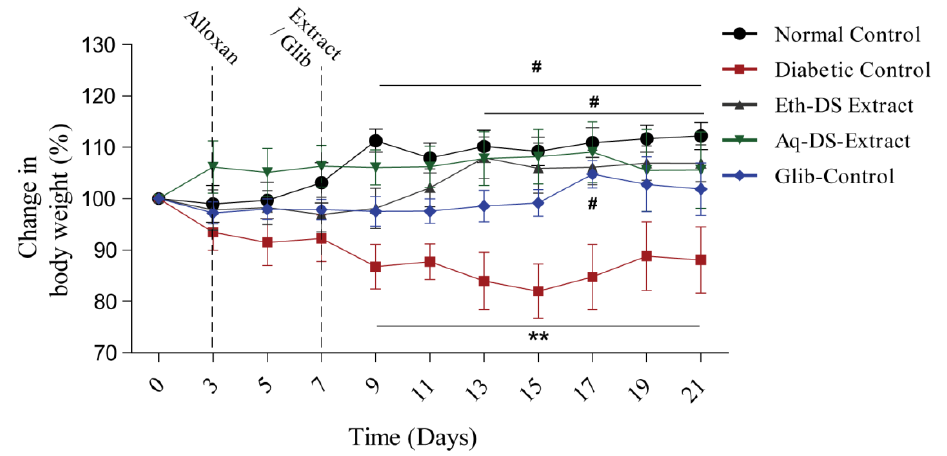
Figure 4. Variability in the body weight percentage (Mean ± SD, n = 6) of diabetic mice treated with glibenclamide and DS extracts, # p < 0.05, ** p < 0.01. (Eth-DS. Ethanolic extract of DS, Aq-DS. Aqueous extract of DS, Glib. glibenclamide treated group).